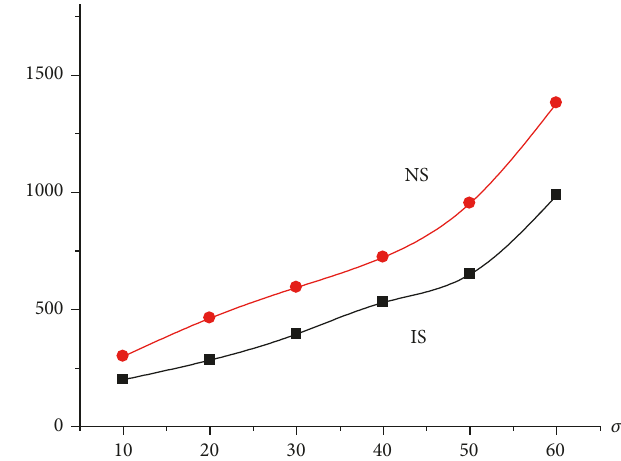
Figure 6: Demand uncertainty versus the manufacturer’s costs under two cases.